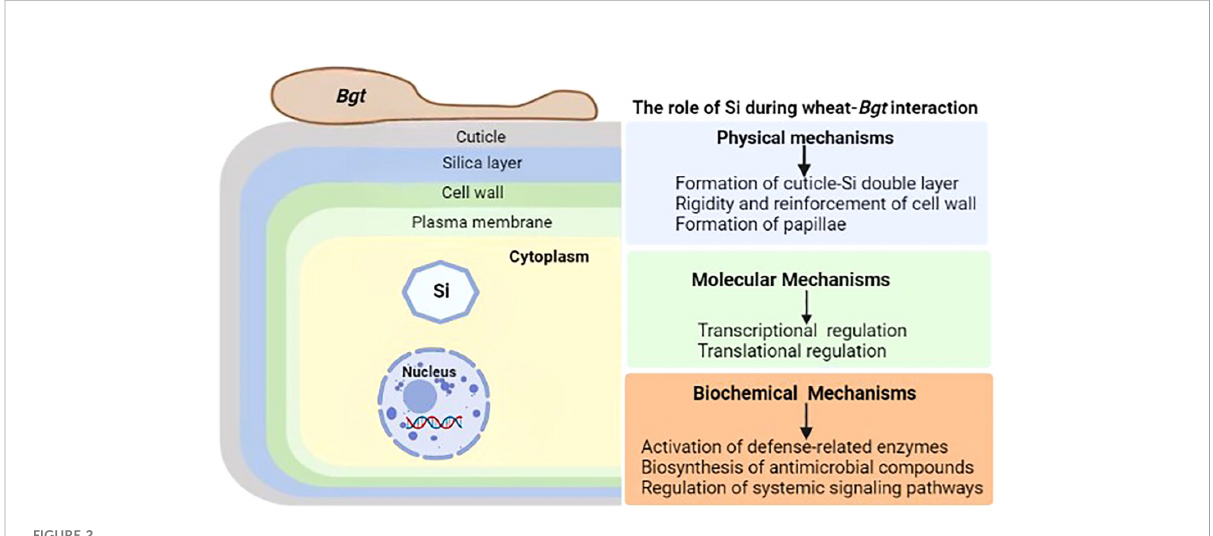
FIGURE 2 General illustration of the role of silicon (Si) during wheat- Bgt interactions. Wheat defense responses mediated by Si are generally classi fi ed into physical, molecular and biochemical mechanisms. Physical mechanisms involve the formation of cuticle-Si double layer, reinforcement of cell wall and papillae formation. Molecular mechanisms involve the transcriptional and translational regulation of key defense-related genes and proteins. Biochemical mechanisms are attributed to the activation of defense-related enzymes, stimulation of antimicrobial compounds biosynthesis and regulation of the complex systemic network of signaling